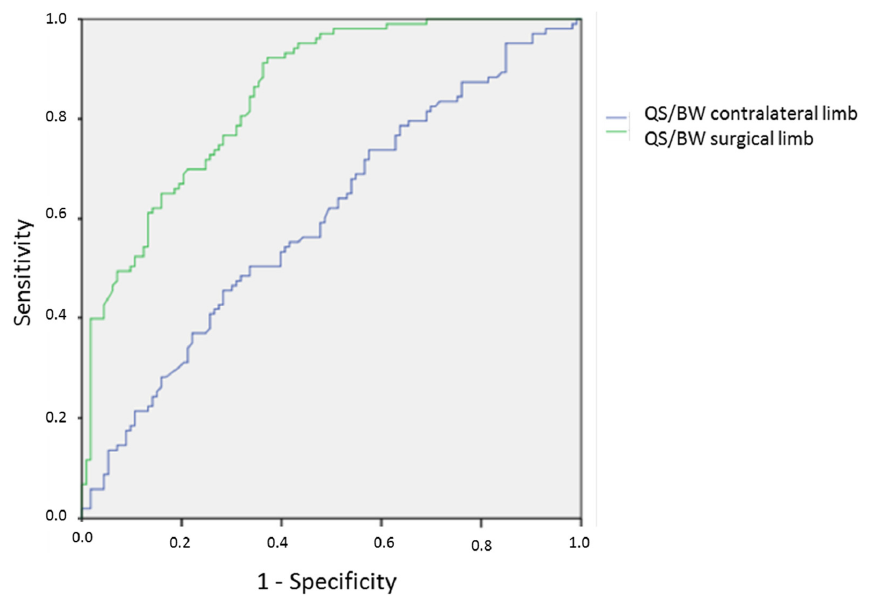
Figure 3. Receiver operating characteristic (ROC) curve area to return to running with QS/BW at 60 ◦ /s in surgical and contralateral knee. Abbreviations: QS: quadriceps strength; BW: body weight. Table 7. Cut-off, sensitivity, specificity, and likelihood ratio for predictive knee parameters. ROC Curve Area Cut-Off (Nm/kg) QS/BW at 60°/s [95%CI] [95%CI]